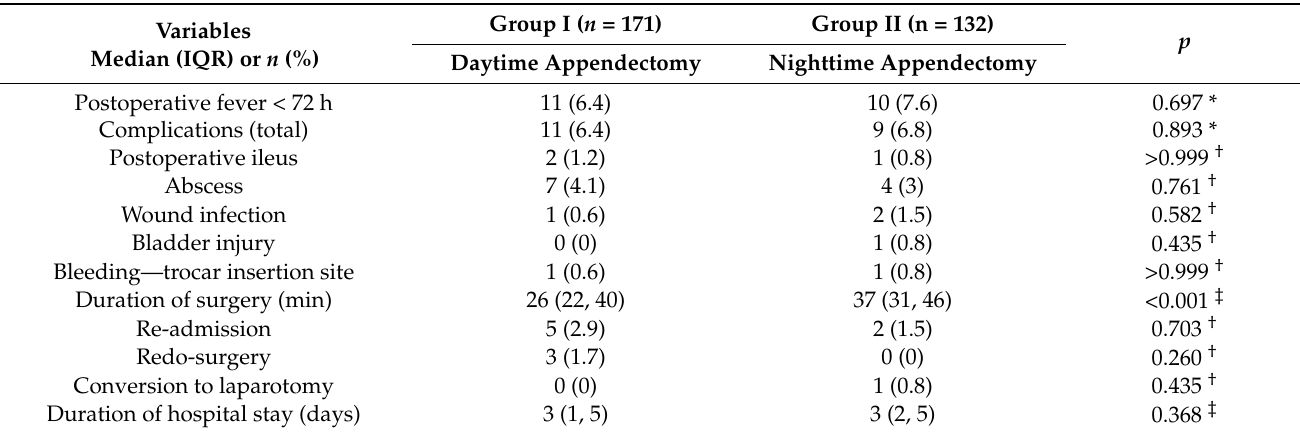
Table 3. Treatment outcomes between the